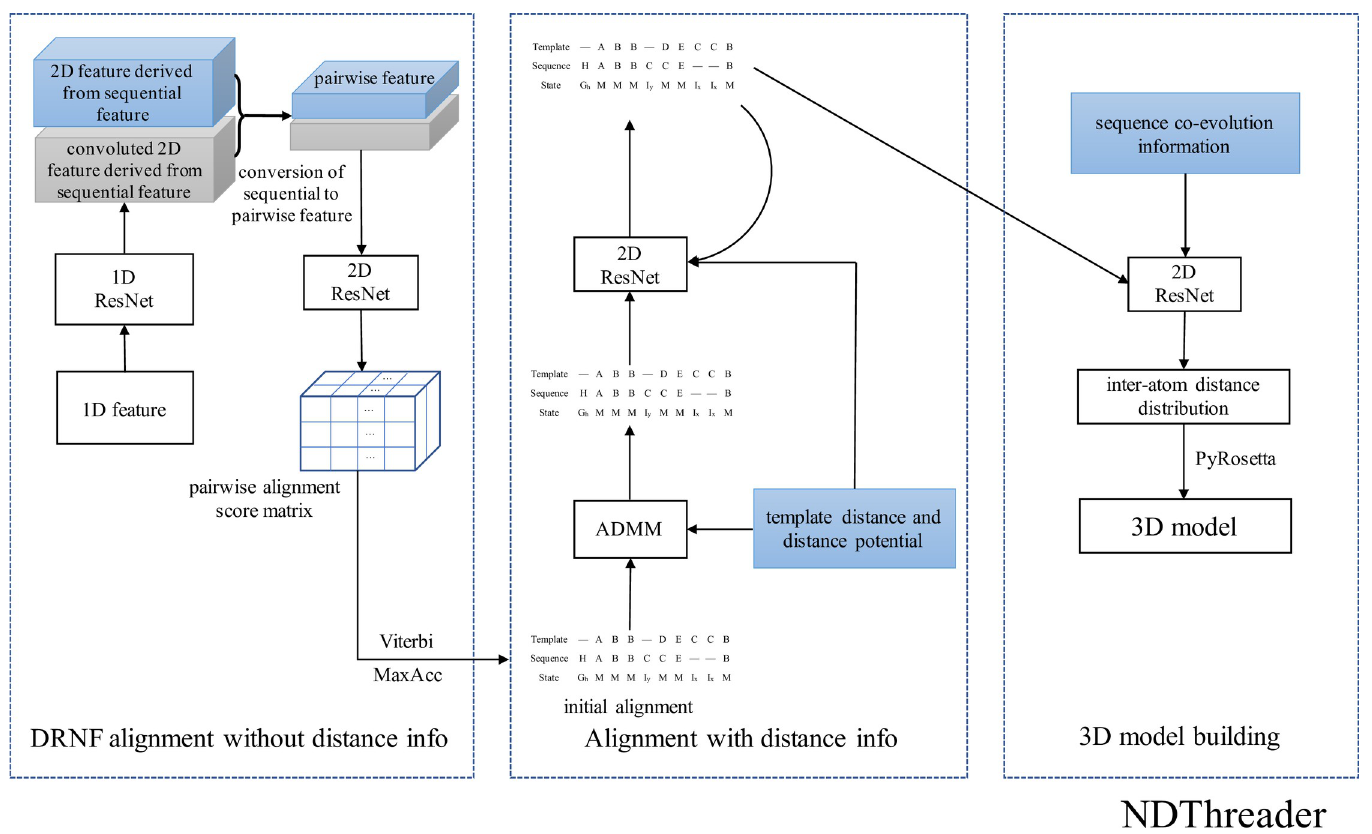
Fig 1. The overall architecture of our template-based modelling method.